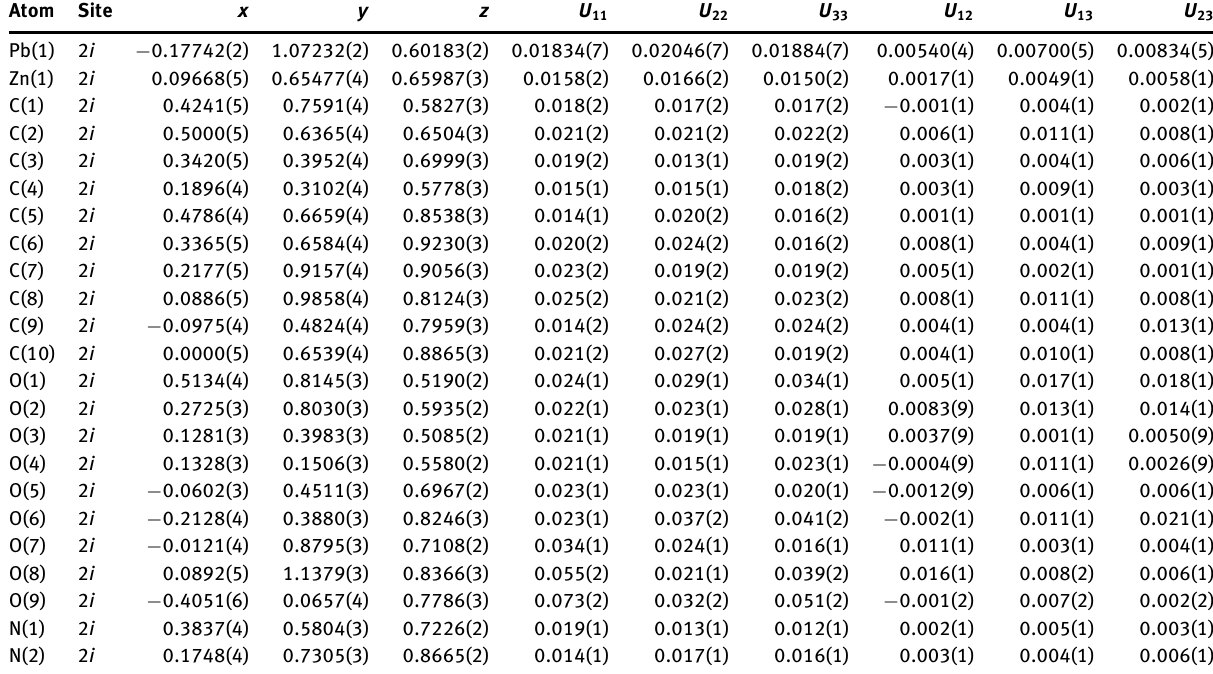
Table 3: Atomic displacement parameters (Å 2